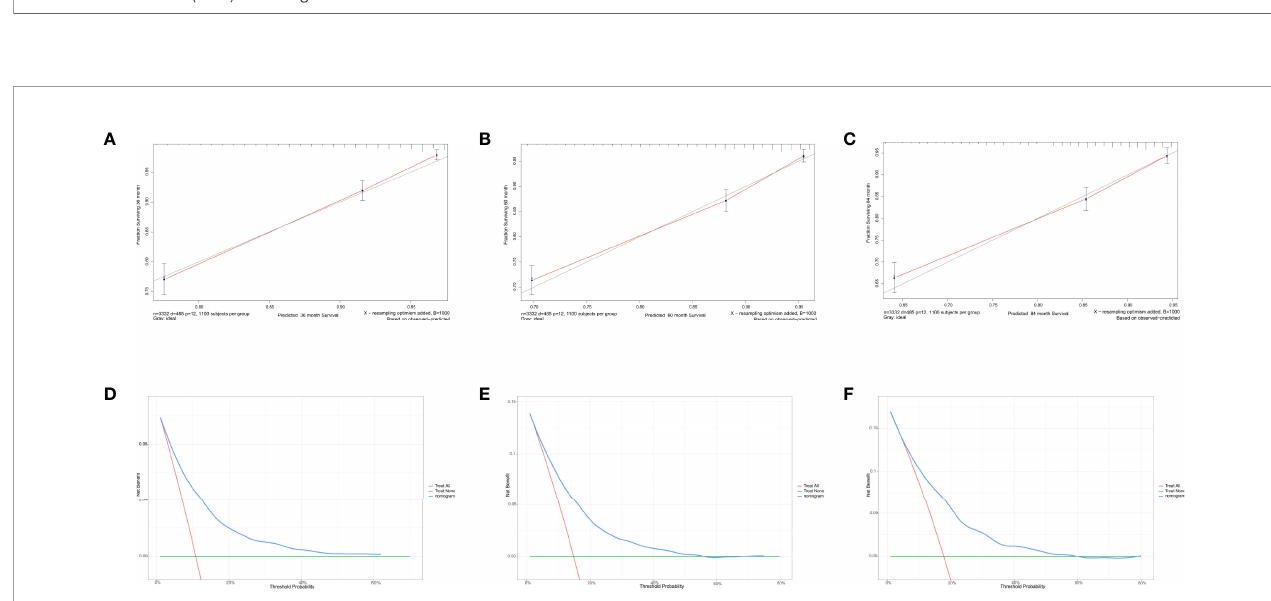
FIGURE 9 | Calibration curves and decision curve analysis for evaluating the accuracy of the nomogram in predicting cancer-speci fi c survival. The solid red line represents the performance of the nomogram, of which the closer fi t to the gray line represents the better prediction of the nomogram we constructed. (A) 3-year CSS in elderly primary operable TNBC patients; (B) 5-year CSS in elderly primary operable TNBC patients; (C) 7-year CSS in elderly primary operable TNBC patients; (D) DCA for 3-year CSS in elderly primary operable TNBC patients in the training cohort; (E) DCA for 5-year CSS in elderly primary operable TNBC patients in the training cohort; (F) DCA for 7-year CSS in elderly primary operable TNBC patients in the training cohort. CSS, cancer-speci fi c survival; DCA, decision curve analysis; TNBC, triple-negative breast